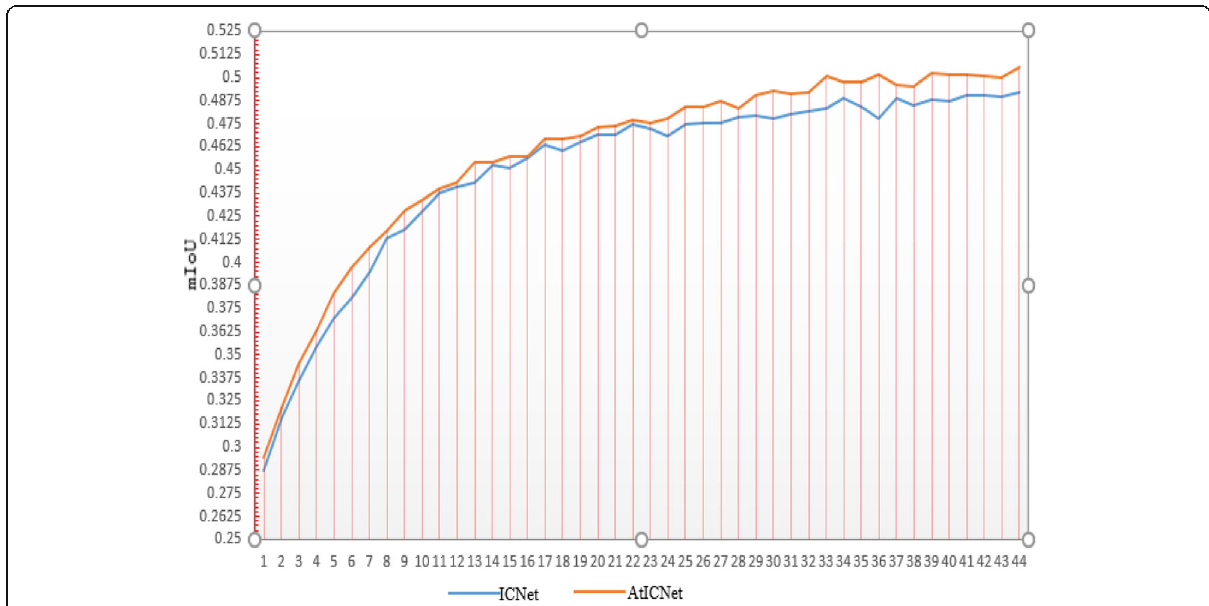
Fig. 3 AtICNet and ICnet network training mIoU. It can be seen that Atrous ICNet ’ s MIoU is higher than